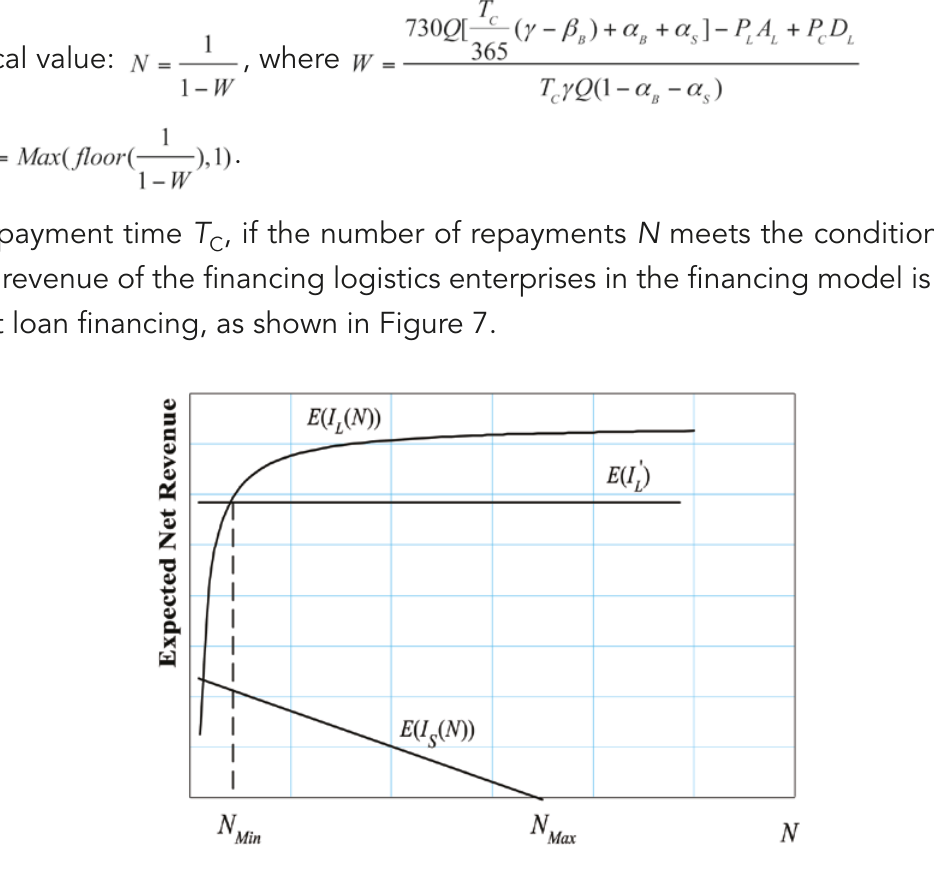
Figure 7: The expected net revenue and number of repayments N